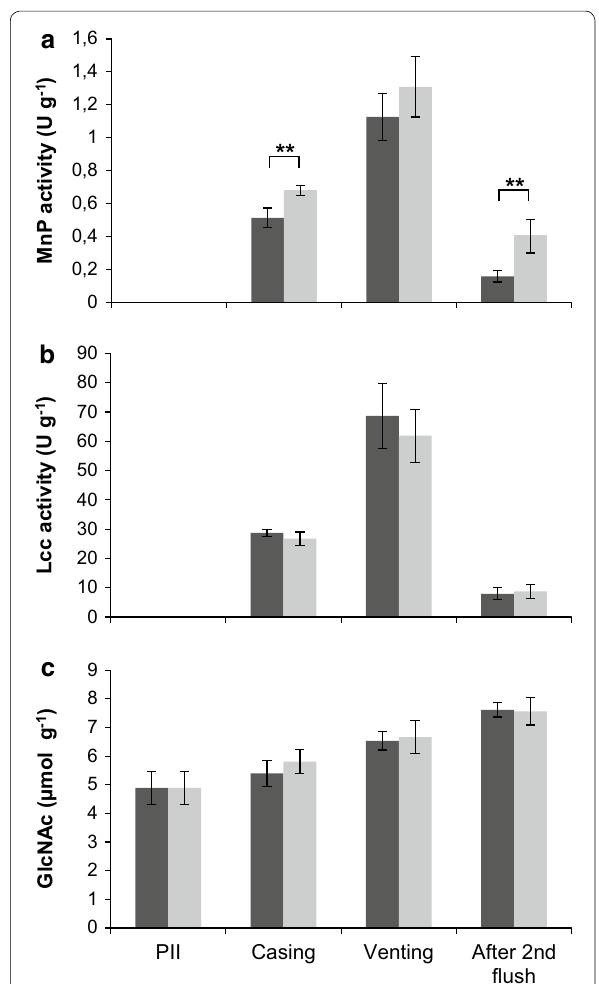
Fig. 2 MnP ( a ) and Lcc ( b ) activity and GlcNAc release ( c ) in a semi-commercial cultivation of A15 ( dark grey shading ) and the MnP overexpressor MnP1-1 ( light grey shading ). Significant differences between A15 and MnP1-1 at each time point are indicated. Signifi- cant differences between time points are presented in Additional file 1: Table S2. Error bars represent standard deviation of